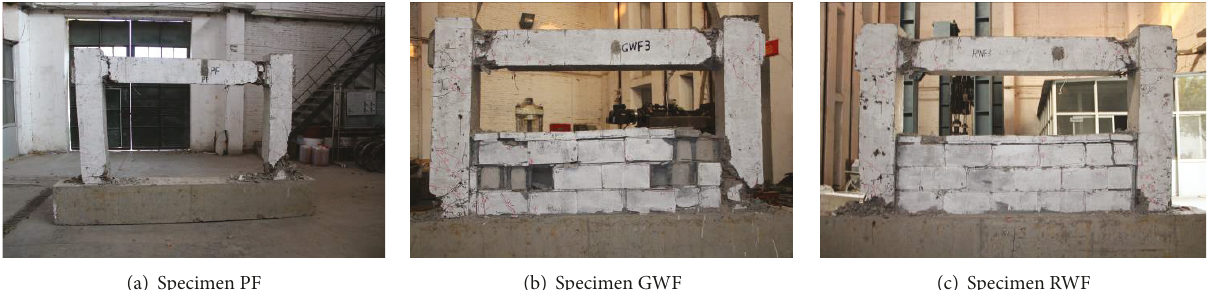
Figure 6: Strain gauge layout in the bars of beams and columns.